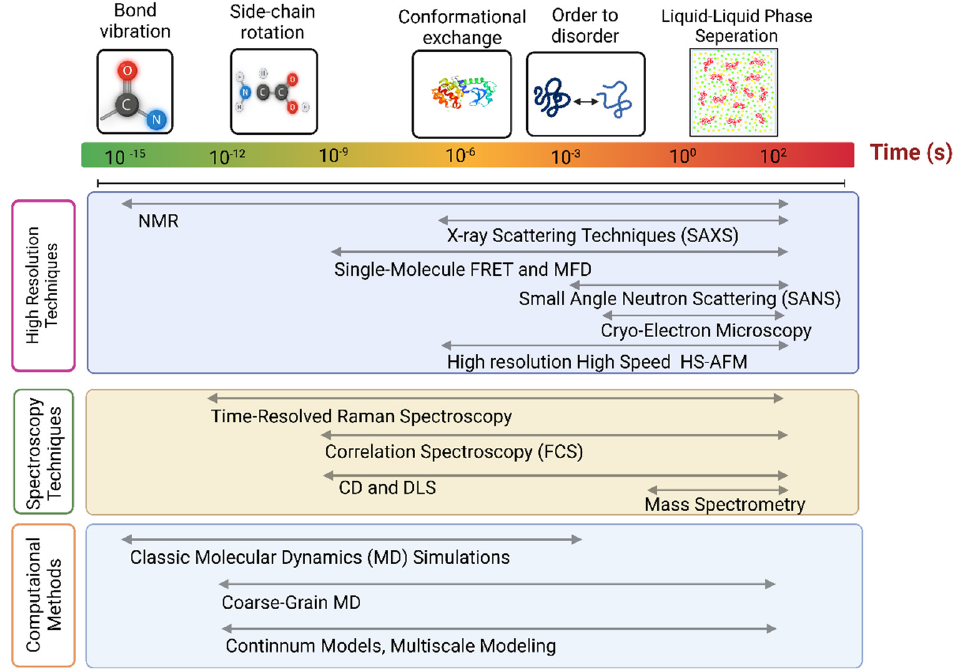
Figure 1. Comparison of sensitivities of methods commonly applied in IDP studies. Limits on temporal resolutions are not intended to be precise in this figure.